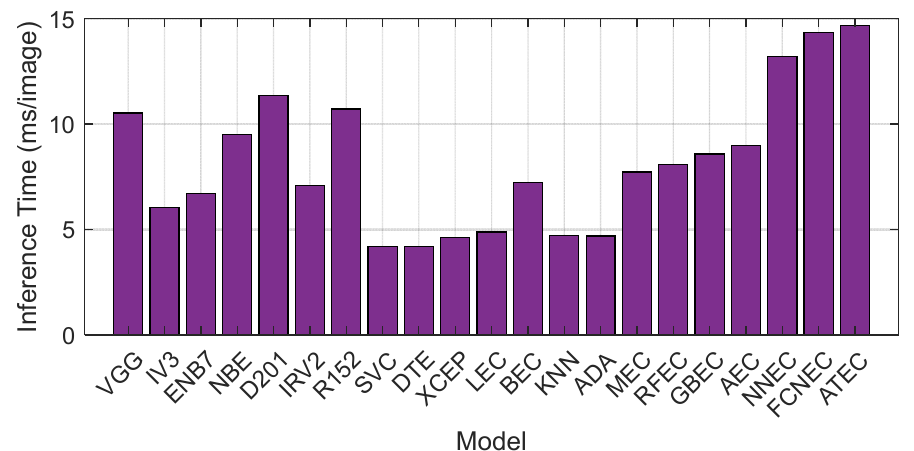
Figure 20. Inference Time of Ensemble Models.